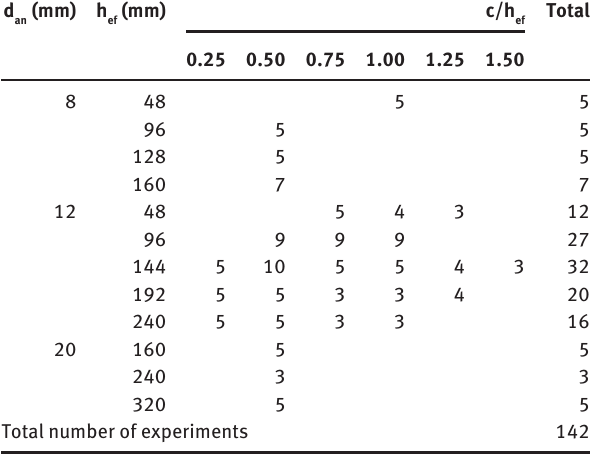
Table 1 Experimental data distribution for single anchors (adapted from [16] ).